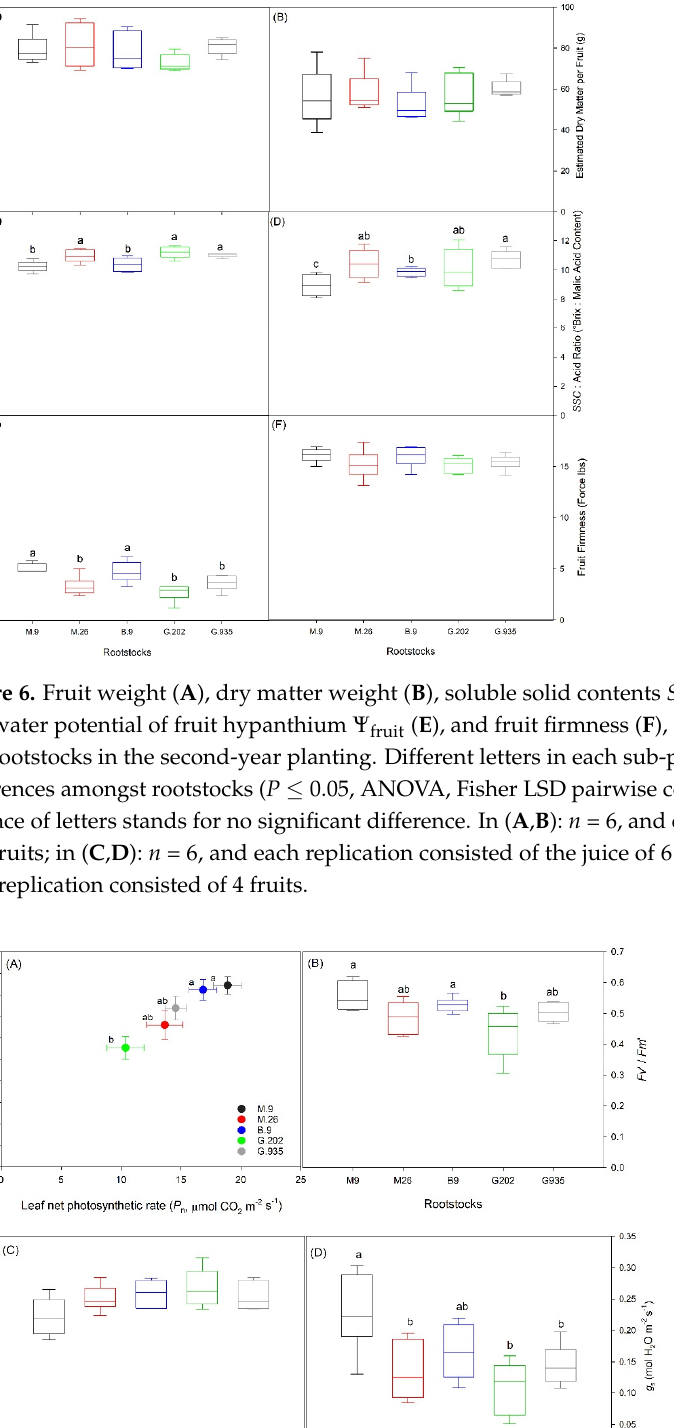
Figure 8. Leaf transpiration and its relationship to the tissue surface temperature of Ambrosia TM apple on five rootstocks at the onset of heat stress in the second-year planting. ( A ) Transpirational rate T r of leaves on vegetative branches and on fruiting spurs; ( B ) relationship between leaf T r and water potential of fruit hypanthium Ψ fruit ; ( C ) relationship between leaf